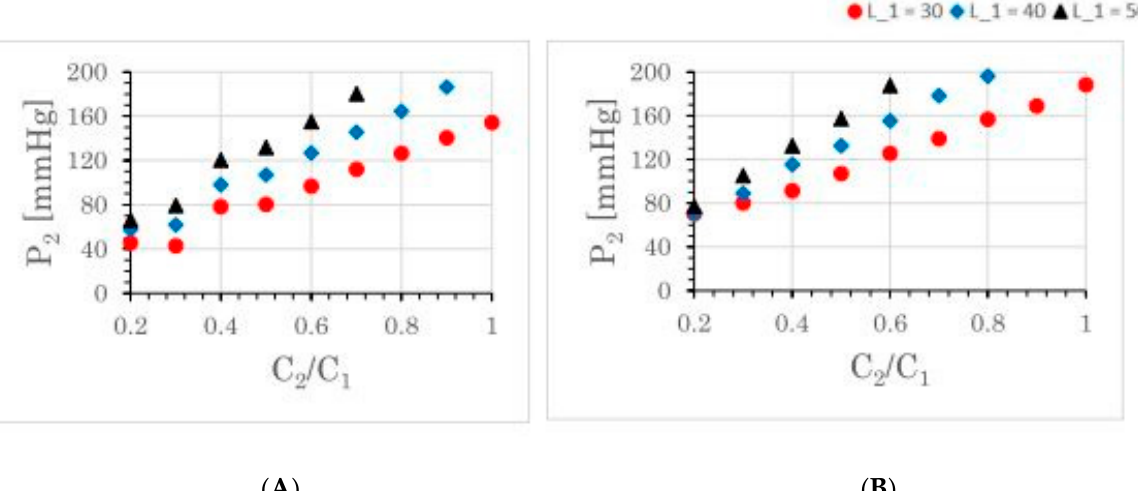
Figure 4. Maximum value of local blood pressure P 2 depending on the size of daughter aneurysms. By fixing the size parameter C 1 of mother aneurysm, the size ratio between mother and daughter aneurysms is changed as C 2 / C 1 = 0.20, 0.30, … 1.00 for a fixed C 1 = 0.10. C 2 / C 1 = 1.00 corresponds to the ideal dumbbell shape. Note that the blood flow and blood pressure in the artery are almost unchanged (yellow and red ones in Figure 3), while local flows F 1 and F 2 and local pressures P 1 and P 2 easily change their maximum amplitude depending on the parameter. For the growth of daughter aneurysm, an ordinary scenario with L 1 = 2 L 2 is demonstrated in the left panel ( A ), and a solitonic scenario with L 1 = L 2 is demonstrated in the right panel ( B ) (cf. Section 2.2). In all the presented cases, P 1 is no more than 170 mmHg.